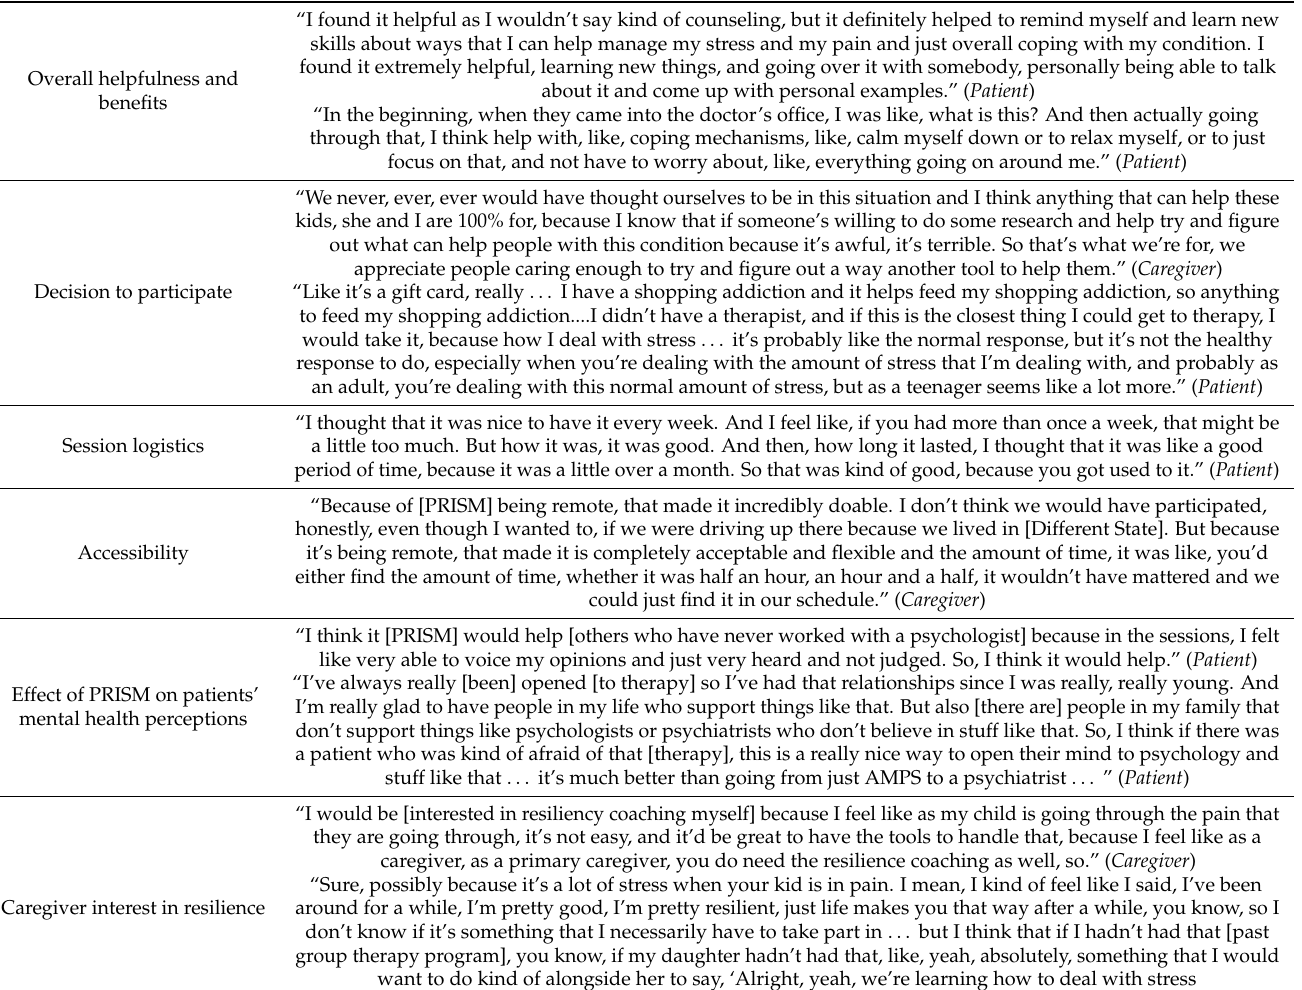
Table 4. Patient and caregiver feedback on